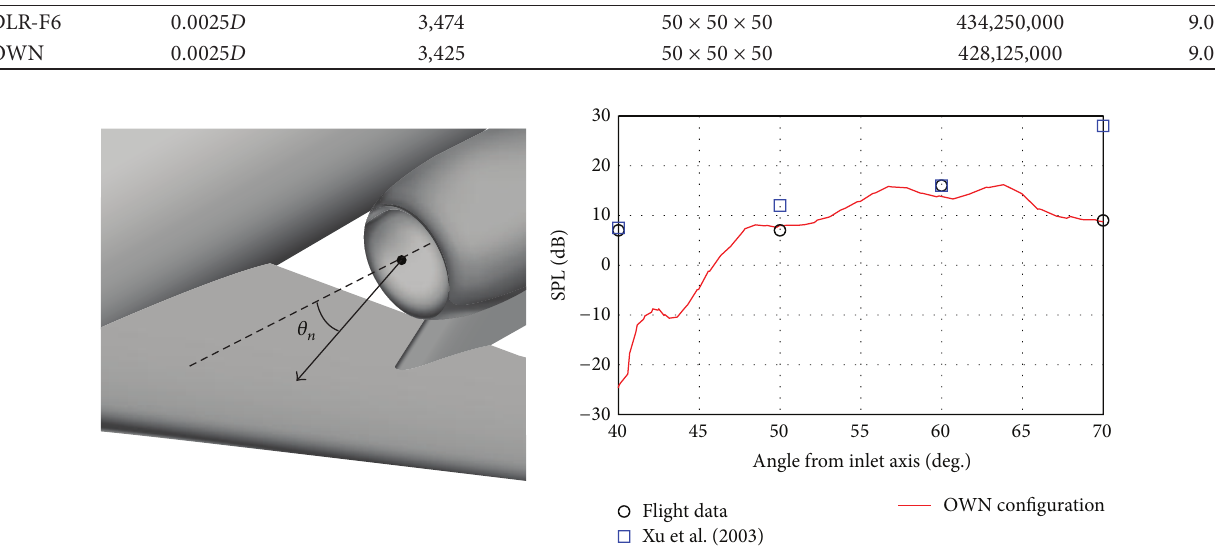
Figure 17: Sound pressure level (SPL) distributions on the main wing